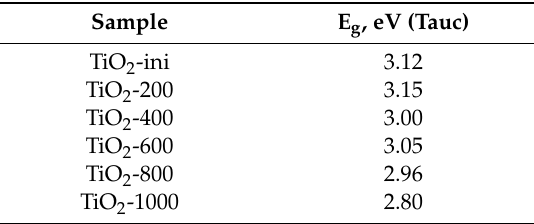
Table 3. Band gap values for the samples determined at (F(R)h υ ) 1 / 2 .